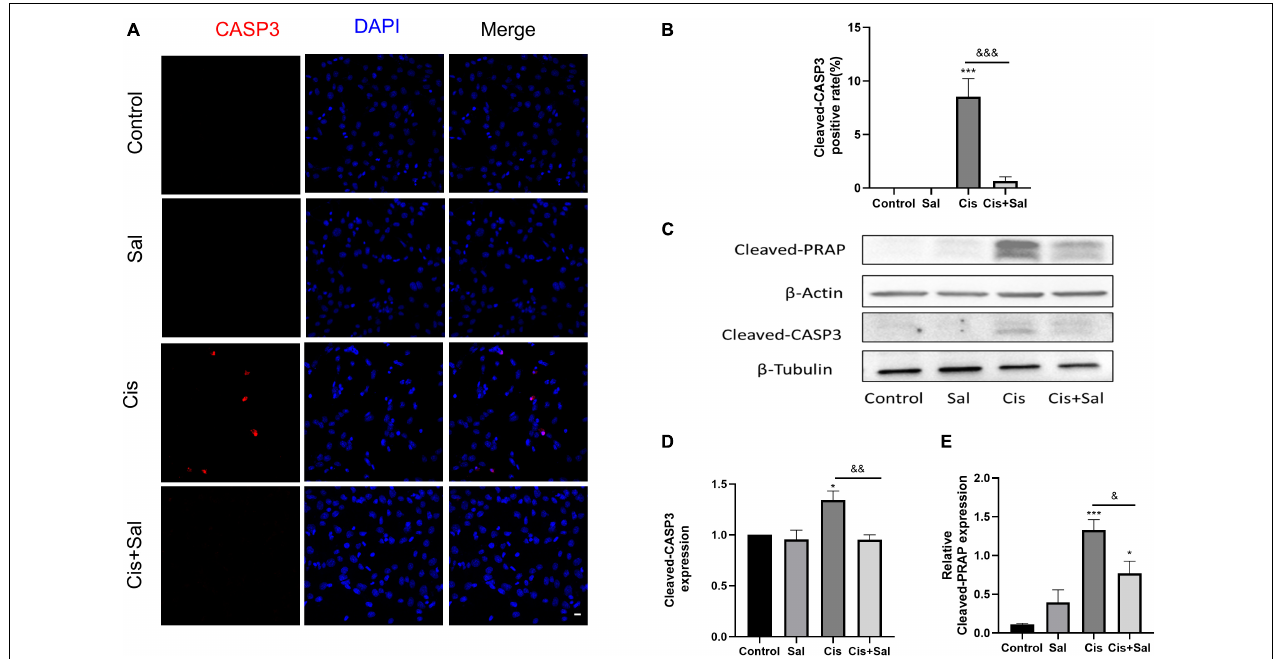
FIGURE 2 | Sal reduces cisplatin-induced apoptosis in HEI-OC1 cells. (A) Cleaved caspase 3 (red) and DAPI (blue) double staining showing apoptotic cells after the different treatments ( n = 3). (B) Quantitative analysis of apoptotic cells in (A) . (C) Western blotting results showing cleaved PARP ( n = 3) and cleaved caspase 3 ( n = 3) in the different groups. (D,E) Quantitative analysis of the western blotting results in (C) . Values are presented as mean ± SEM from independent experiments. * P < 0.05 and *** P < 0.001 vs. the control group; & P < 0.05, && P < 0.01, and &&& P < 0.001 vs. the cisplatin group. Sal, salubrinal; Cis, cisplatin. Scale bars = 20 µ